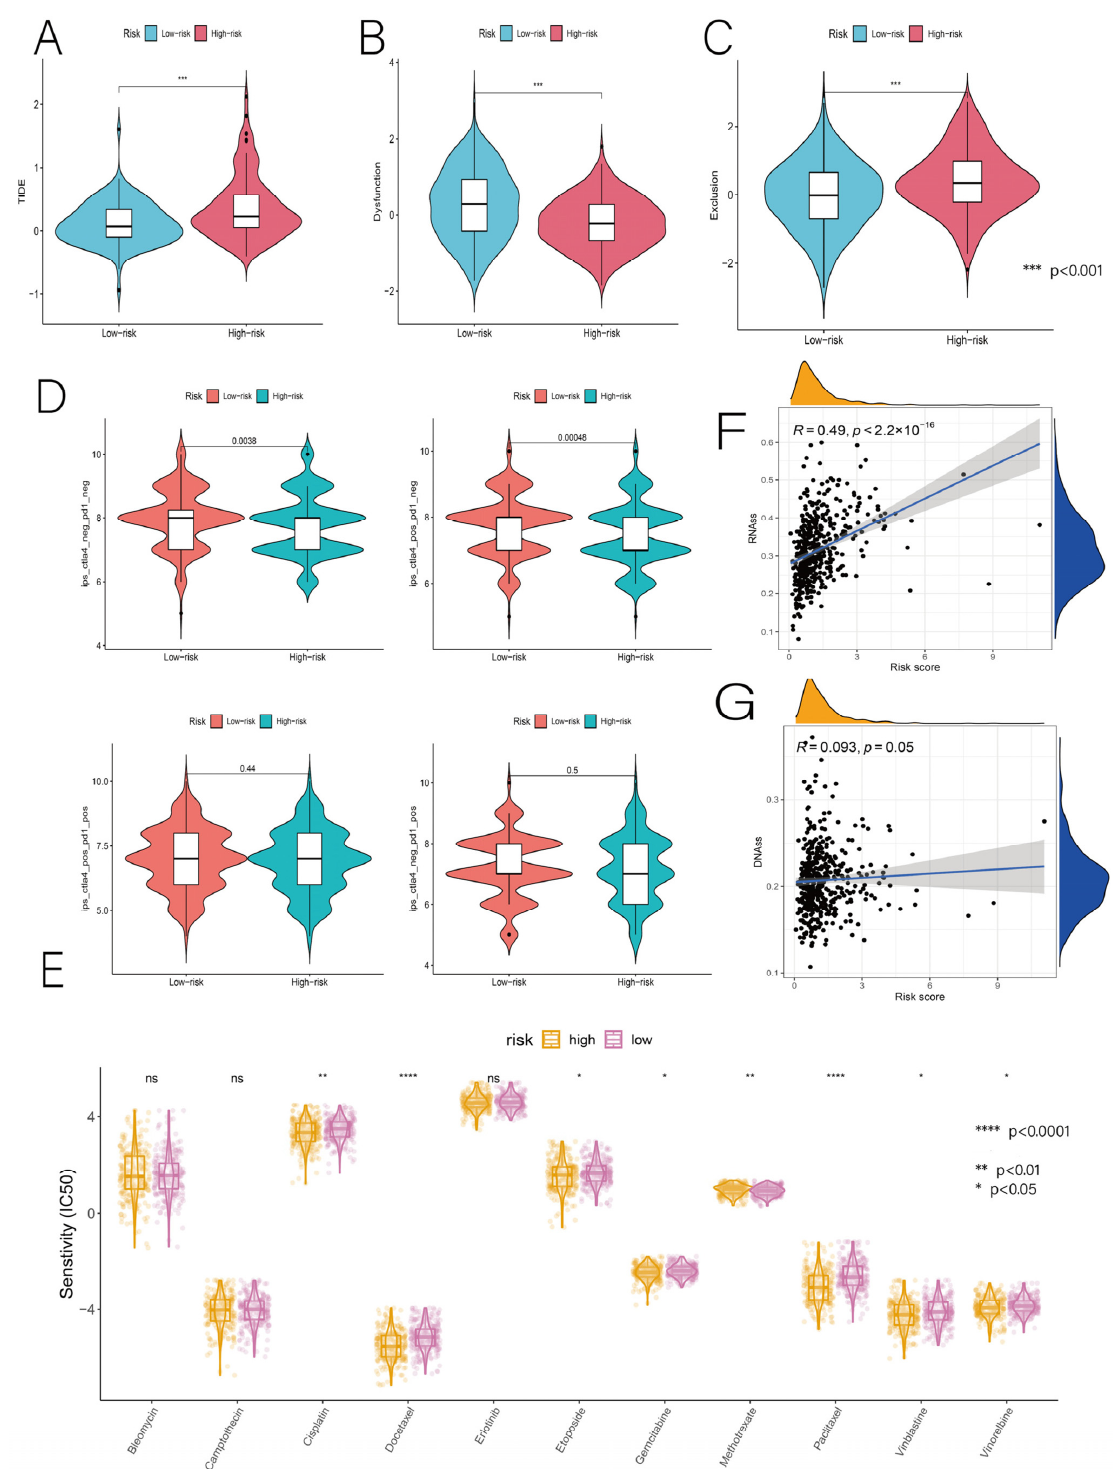
Figure 10. ( A – C ) Relationship between high-risk and low-risk groups and TIDE scores (including TIDE, Dysfunction, and Exclusion). ( D ) Differences in IPS between different risk groups. IPS and IPS- CTLA4 significantly differed between the high-risk and low-risk groups ( p < 0.05). ( E ) Relationship between high-risk and low-risk groups with multiple chemotherapeutic agents commonly used for LUAD. ( F , G ) Relationship between high-risk and low-risk groups with DNAss and RNAss. * p < 0.05, ** p < 0.01, *** p < 0.001, and **** p <